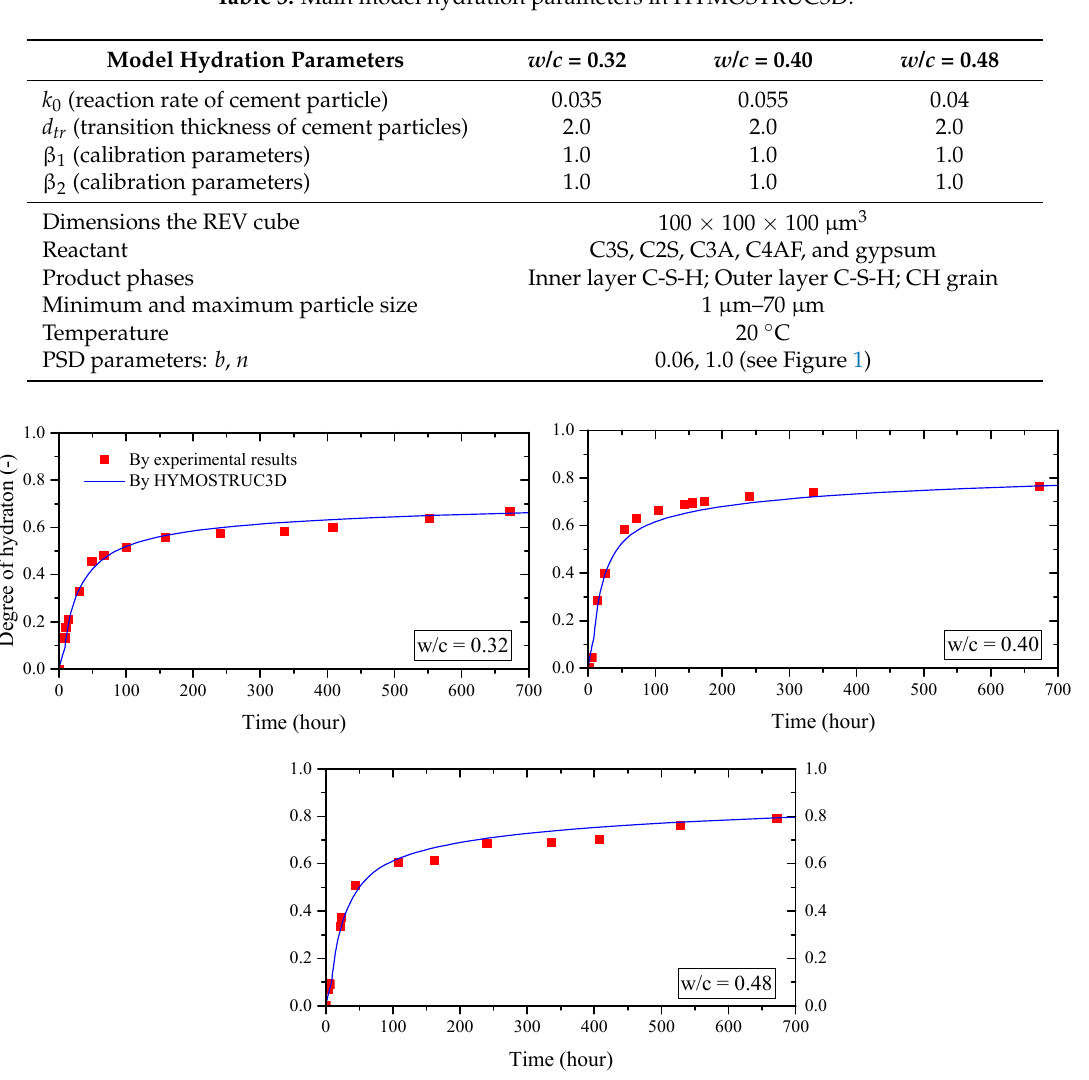
Table 3. Main model hydration parameters in HYMOSTRUC3D.